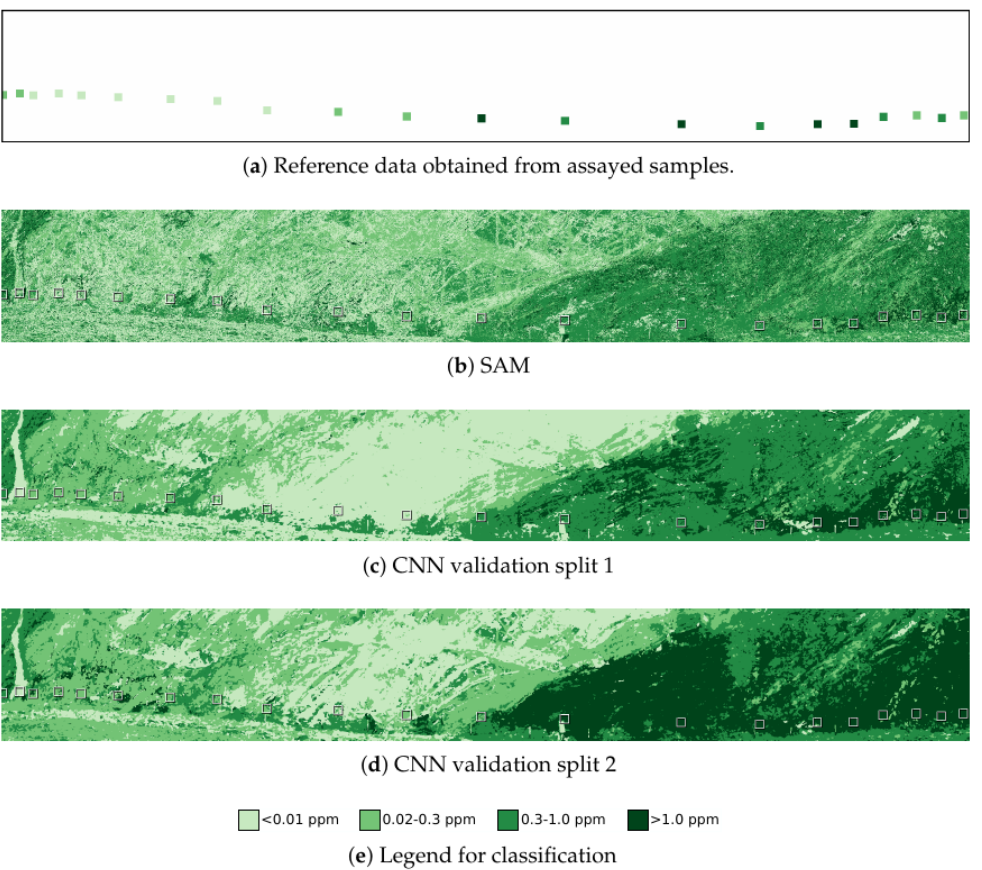
Figure 6. Reference data and results for the four grade classification problem. Reference data show the classes of the assayed samples obtained from the face. Results of the classification for both SAM and the CNN are shown. Classification results are coloured by one of the four grade classifications, as shown in the legend, with a bounding box around the regions labelled in the reference